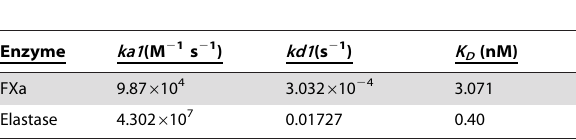
Table 2. Kinetics of FXa and Elastase interactions with